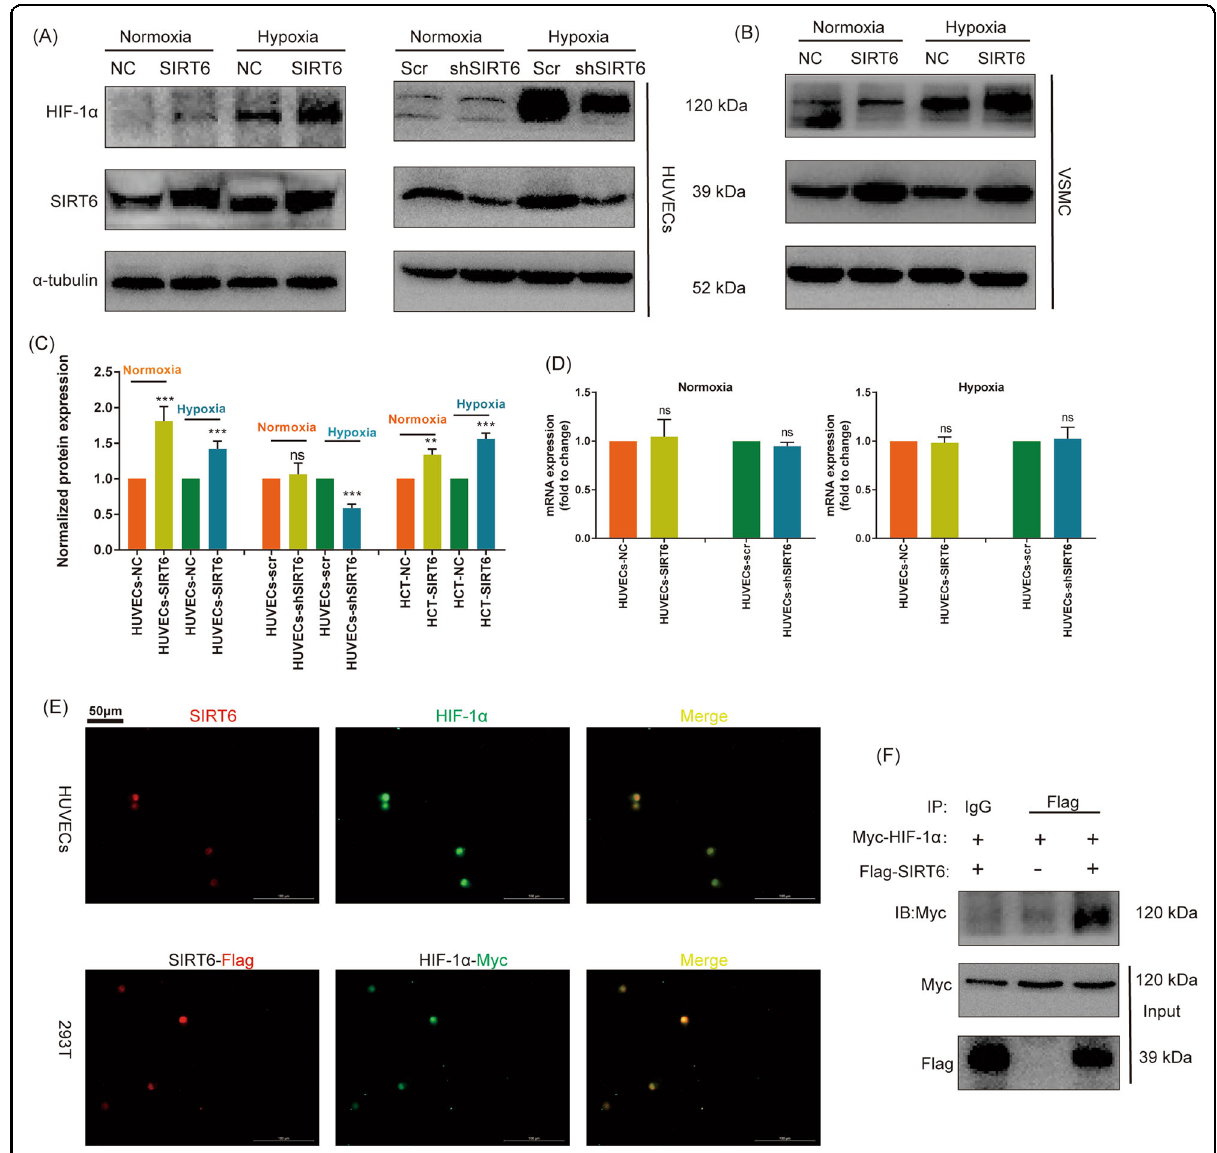
(CoCl 2 ) and normoxia after overexpression and downregulation of SIRT6 in HUVECs. B The expression of HIF-1 α under hypoxia (CoCl 2 ) and normoxia after overexpression of SIRT6 in VSMC. C Quantitative densitometric analysis of HIF-1 α levels in panels A and B . D The mRNA expression of HIF-1 α under hypoxia and normoxia after overexpression and downregulation of SIRT6 in HUVECs performed by RT-qPCR. E Colocalization of HIF-1 α (Myc- tag) and SIRT6 (Flag-tag) under hypoxia in HUVECs and 293T performed by IF (magni fi cation: ×200). F Co-IP of HIF-1 α -Myc and SIRT6-Flag under hypoxia in 293T cell (ns: no signi fi cance, *** P <